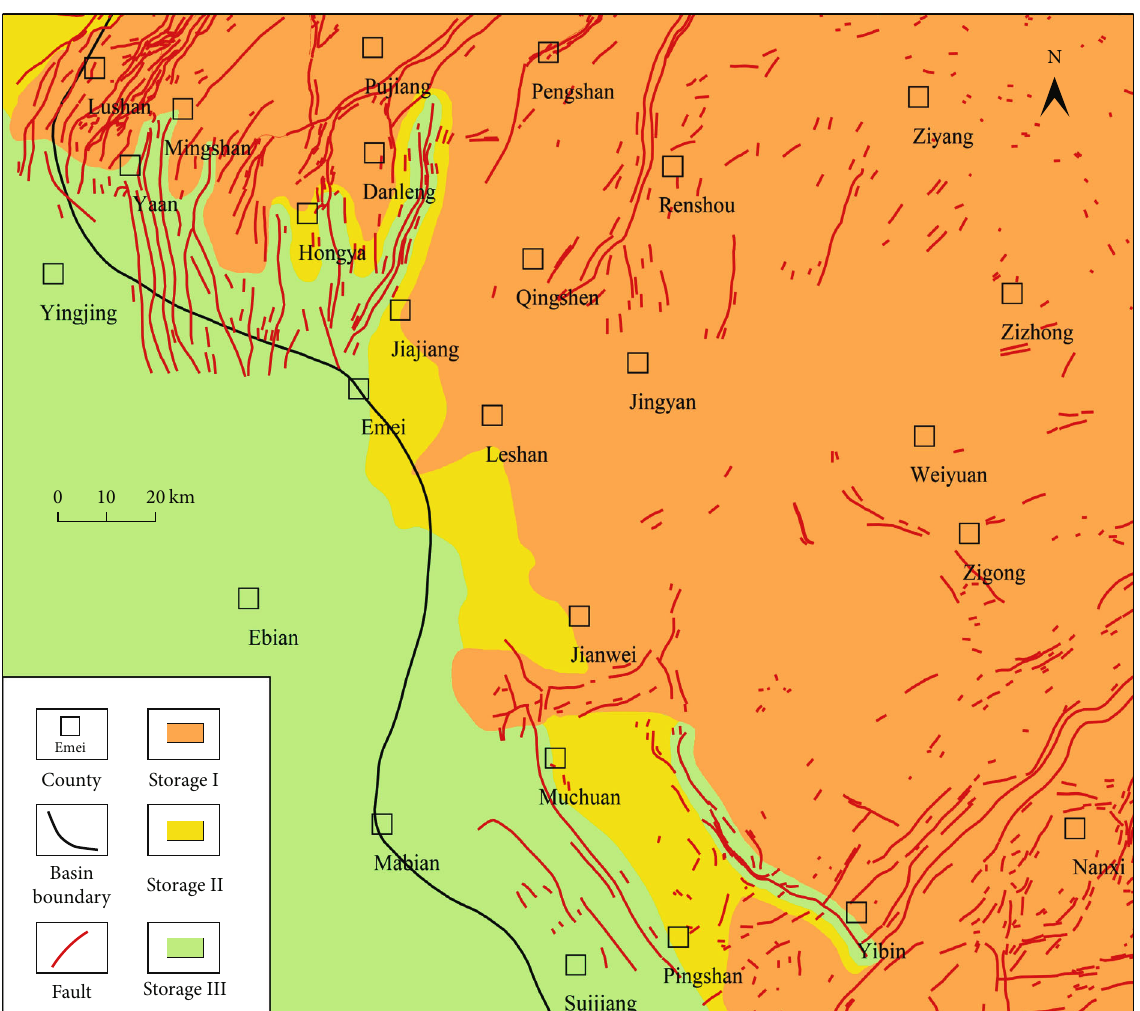
Figure 11: Planar distribution of the comprehensive hydrocarbon preservation evaluation results of Triassic formation in the southwestern part of the Sichuan